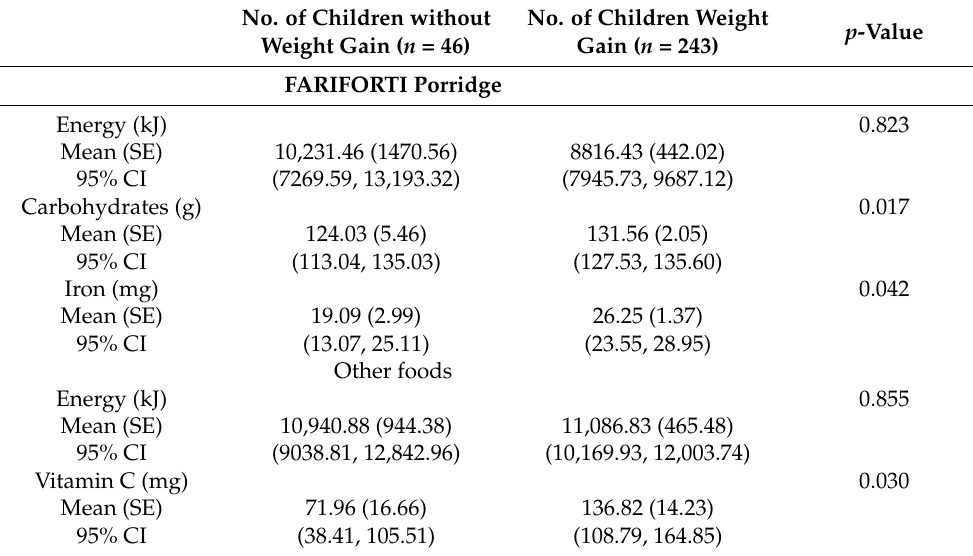
Table 4. Energy and nutrient intakes from the FARIFORTI porridge and other foods consumed during the LNR learning sessions according to weight gain. No. of Children